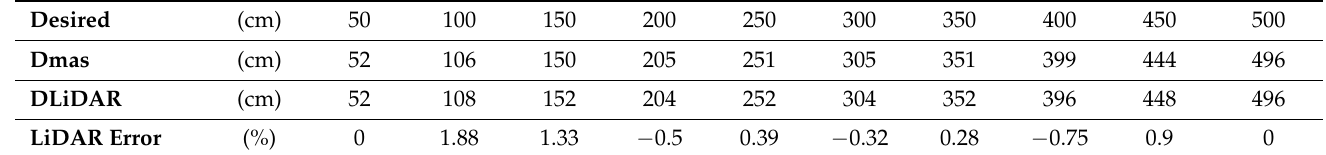
Table 6. Distance measurements with ambient light intensity 14 lux (twilight) and a dark target.